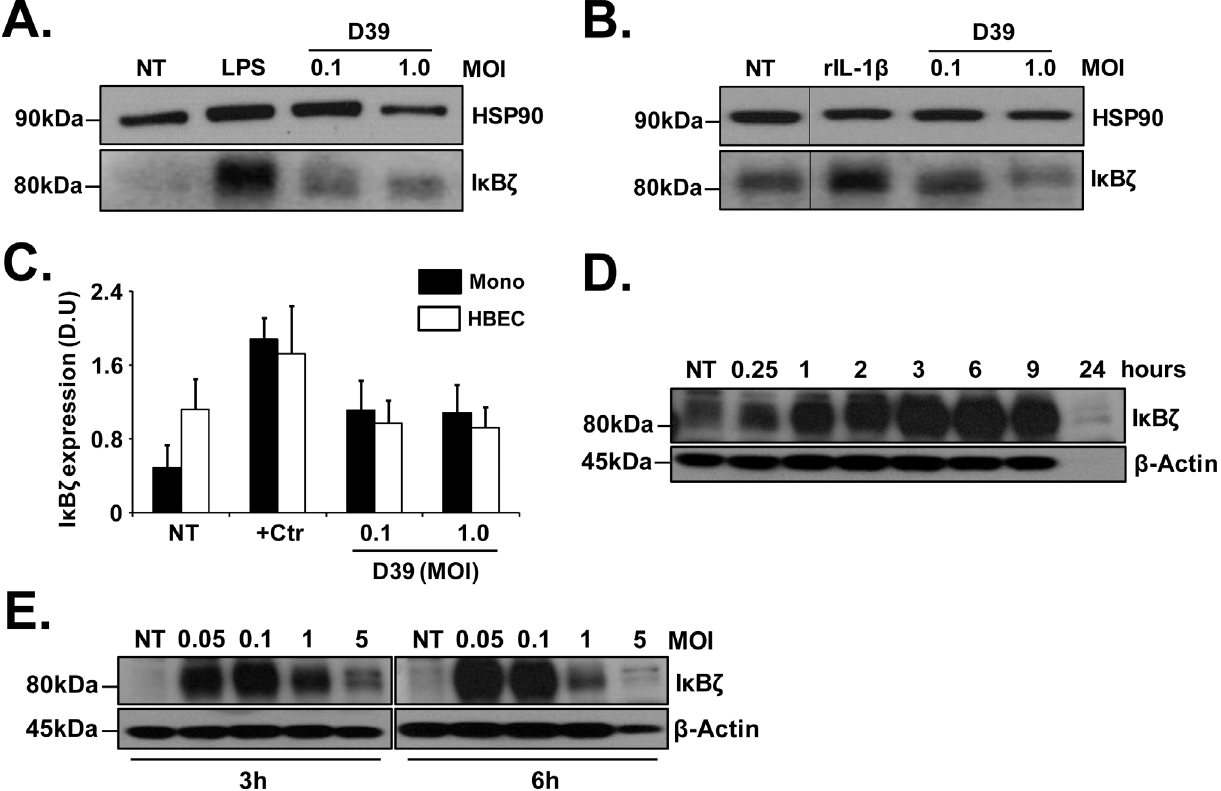
Fig 1. Pneumococcus induced I κ B ζ expression in monocytes. (A) Human monocytes (10 6 cells/ml) or (B) HBECs (5X10 4 cells/33 mm 2 ) were infected with pneumococcus strain D39 at MOIs 0.1 and 1.0 for 3 h. LPS (1 μ g/ml) and rIL-1 β (10ng/ml) were used as positive controls (+Ctr) for monocytes and HBECs respectively. (C) Densitometry graph for I κ B ζ expression normalized to house-keeping proteins HSP90 or β -actin in monocytes from blot (A) and in HBECs from blot (B). (D) Human monocytes (10 6 cells/ml) were infected with D39 at MOI 0.1 for different time points through 24 h or (E) with different MOIs of D39 for 3 and 6h. Cell extracts were analyzed using immunoblotting with anti- I κ B ζ antiserum, HSP90 antibody and β -actin antibody. The immunoblots represent 3 independent experiments. NT stands for not treated. Vertical lines have been inserted to indicate a repositioned gel